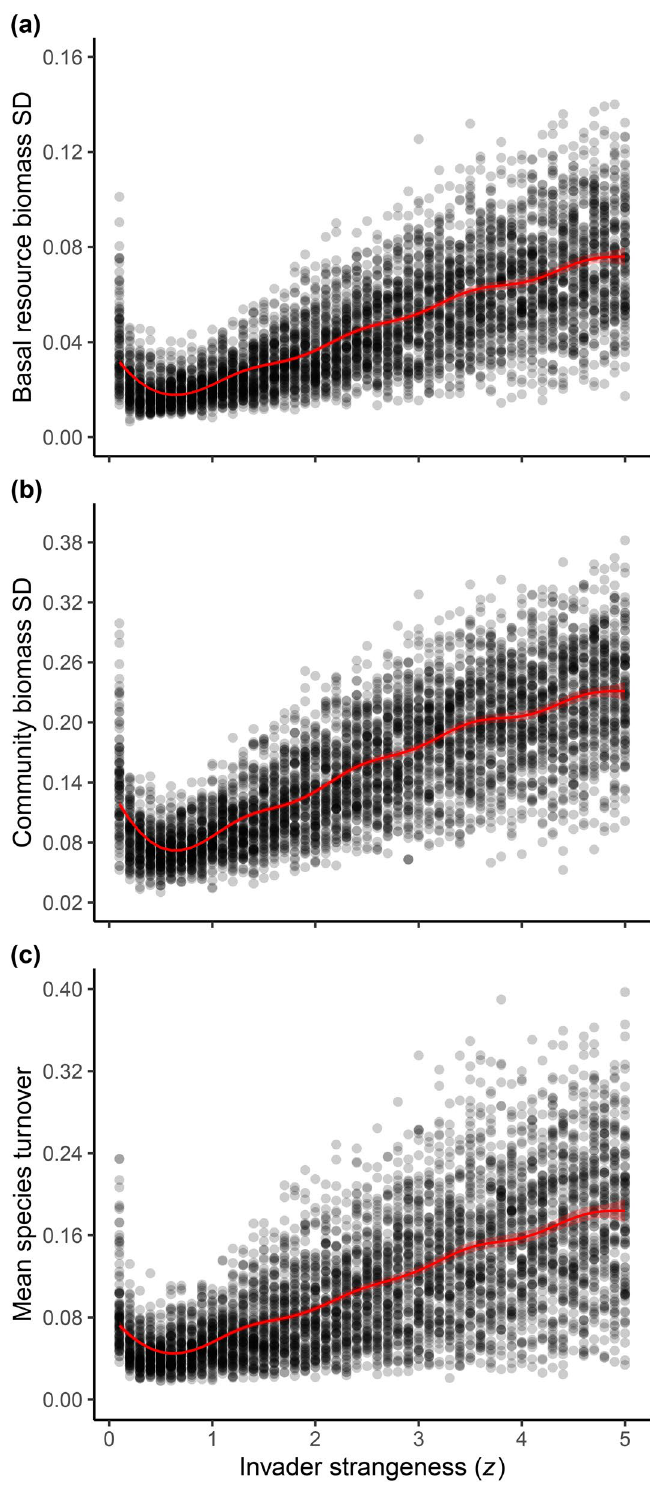
Figure 2. Environmental and community variation. Variation metrics show an overall increase in the variability of communities with increasing invader strangeness ( z ). ( a ) Shows the standard deviation of basal resource biomass and ( b ) community biomass across simulations. ( c ) Shows mean species turnover in communities across simulations, calculated as the proportional change in species composition in communities between time outputs (10,000 time steps). Regression lines depict the best-fit curves from generalized additive models (GAM) to account for the observed non-linearity, fit with gamma error distributions and log link functions. For all figures, 95% confidence intervals are shown by the shadded area around regression